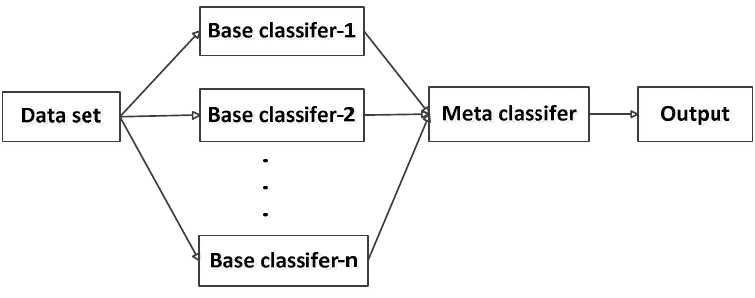
Figure 1. Two-layer Stacking Structure.